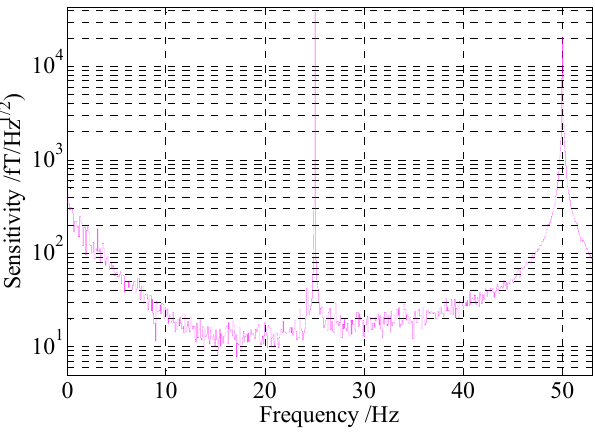
Figure 12. Optimal sensitivity of the atomic magnetometer based on suppressing the noises.